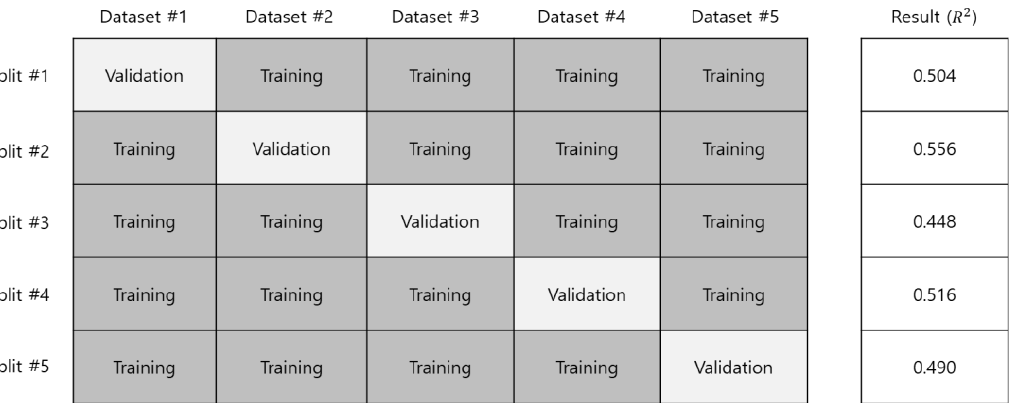
Figure 9. The k-fold cross-validation test results of the proposed model.